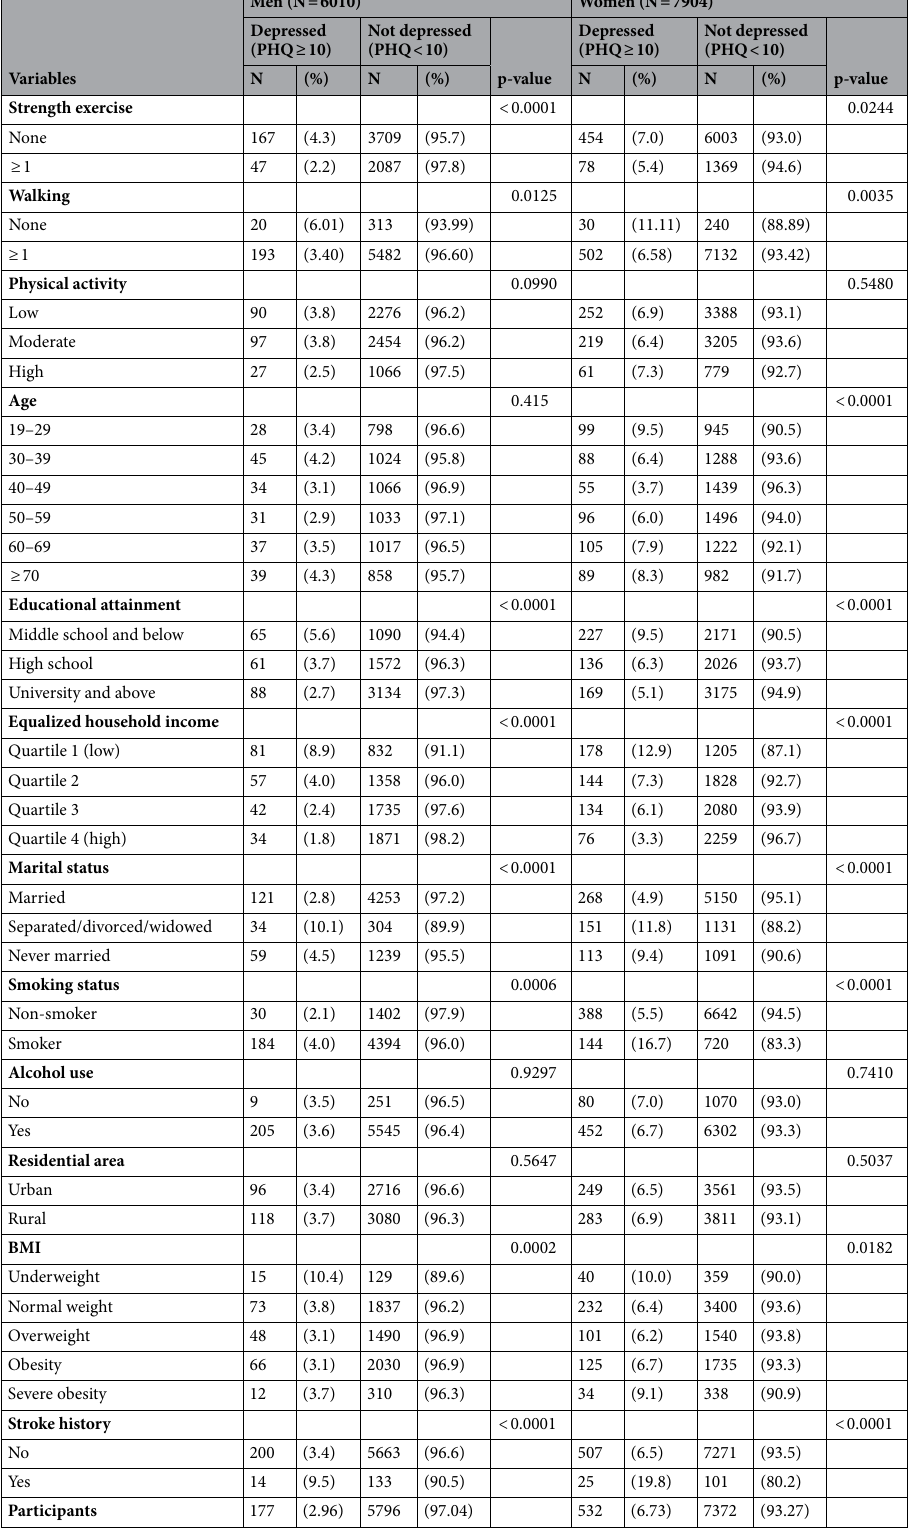
Table 1. Socioeconomic and health-related characteristics of all study participants according to the presence/absence of depression. Variables are presented as numbers and percentages. PHQ-9 Patient